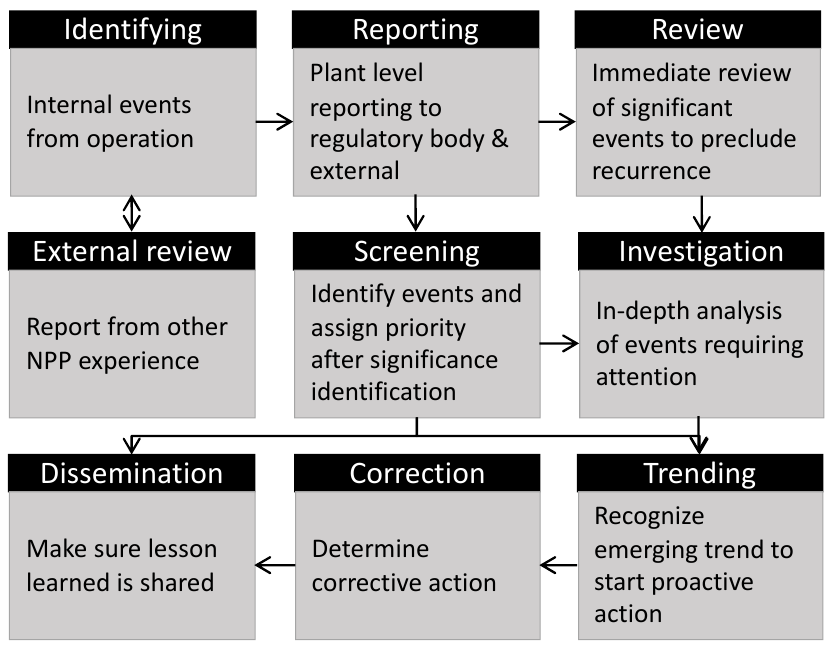
Figure 8. NPP monitoring and screening mechanism, own elaboration based on [44].